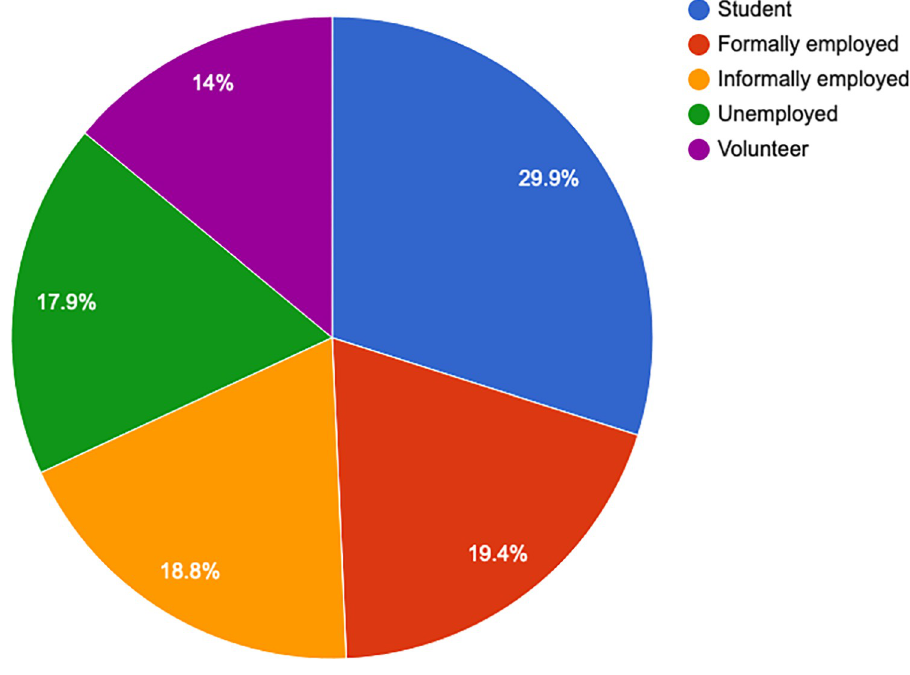
Contraception The majority, 69.3% (n = 232), had never used any form of contraception. For those who had, the most used methods were male condoms (66.3%, n = 67) and emergency contraception